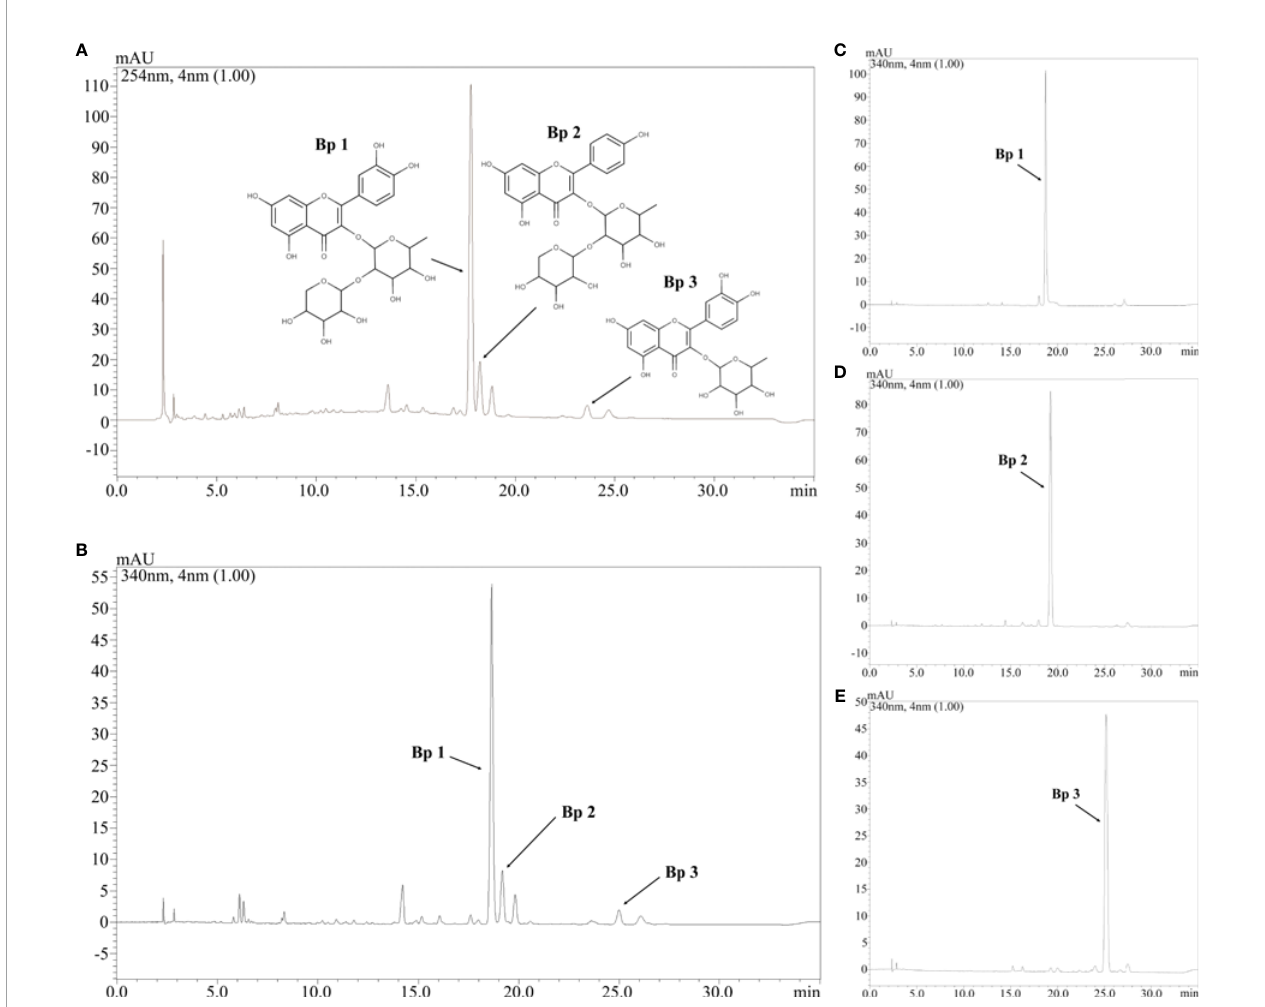
FIGURE 1 | Chromatogram of hydroethanolic extract from B. pinnatum leaf (HEBP) at UV 254 (A) and 340 (B) nm and chromatogram at UV 340 nm of Bp1 (C) , Bp2 (D), and Bp3 (E) . Stationary phase: C18 Phenomenex (150x4.6 mm, 2.6 m m) equipped with a Phenomenex security guard column (4.0x2.0 mm ID). Mobile phase: tri fl uoroacetic acid 0.3% and (B) acetonitrile; gradient: 7 – 15% B, 0 – 3 min; 15 – 20% B, 3 – 12 min; 20 – 22% B, 12 – 30 min; fl ow elution 0.7 ml/min; detection 254 and 340